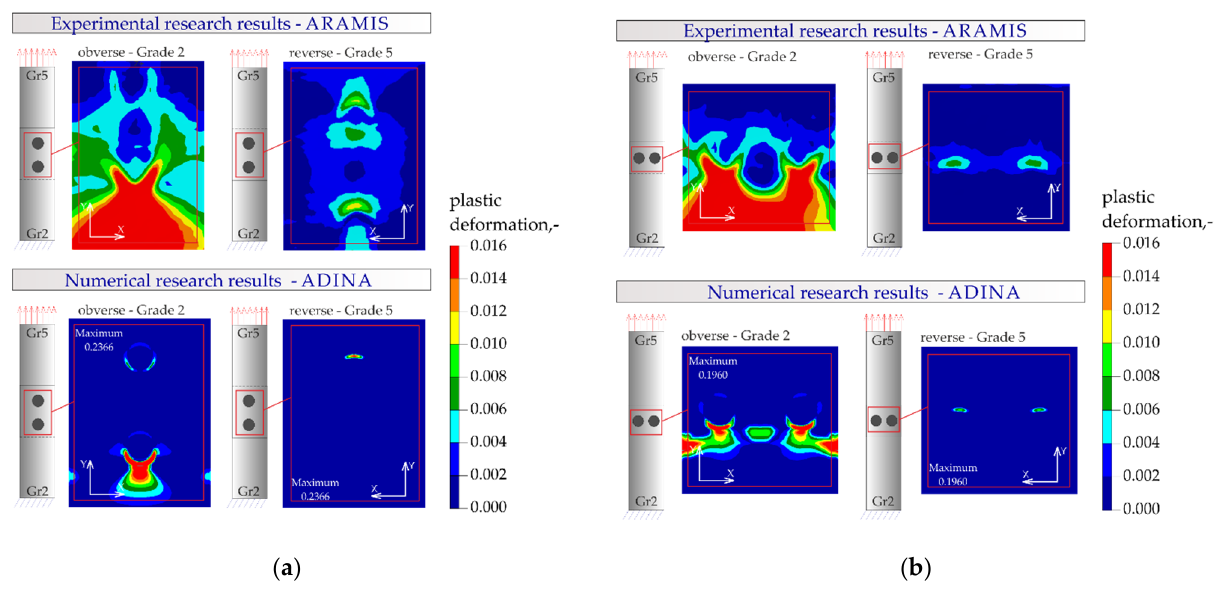
Figure 24. Distribution of plastic deformations: ( a ) in the joints with two welds arranged parallel to the direction of tensile shear—Gr2–Gr5.2 and ( b ) in the joints with two welds arranged perpendicular to the direction of tensile shear—Gr2–Gr5.3.